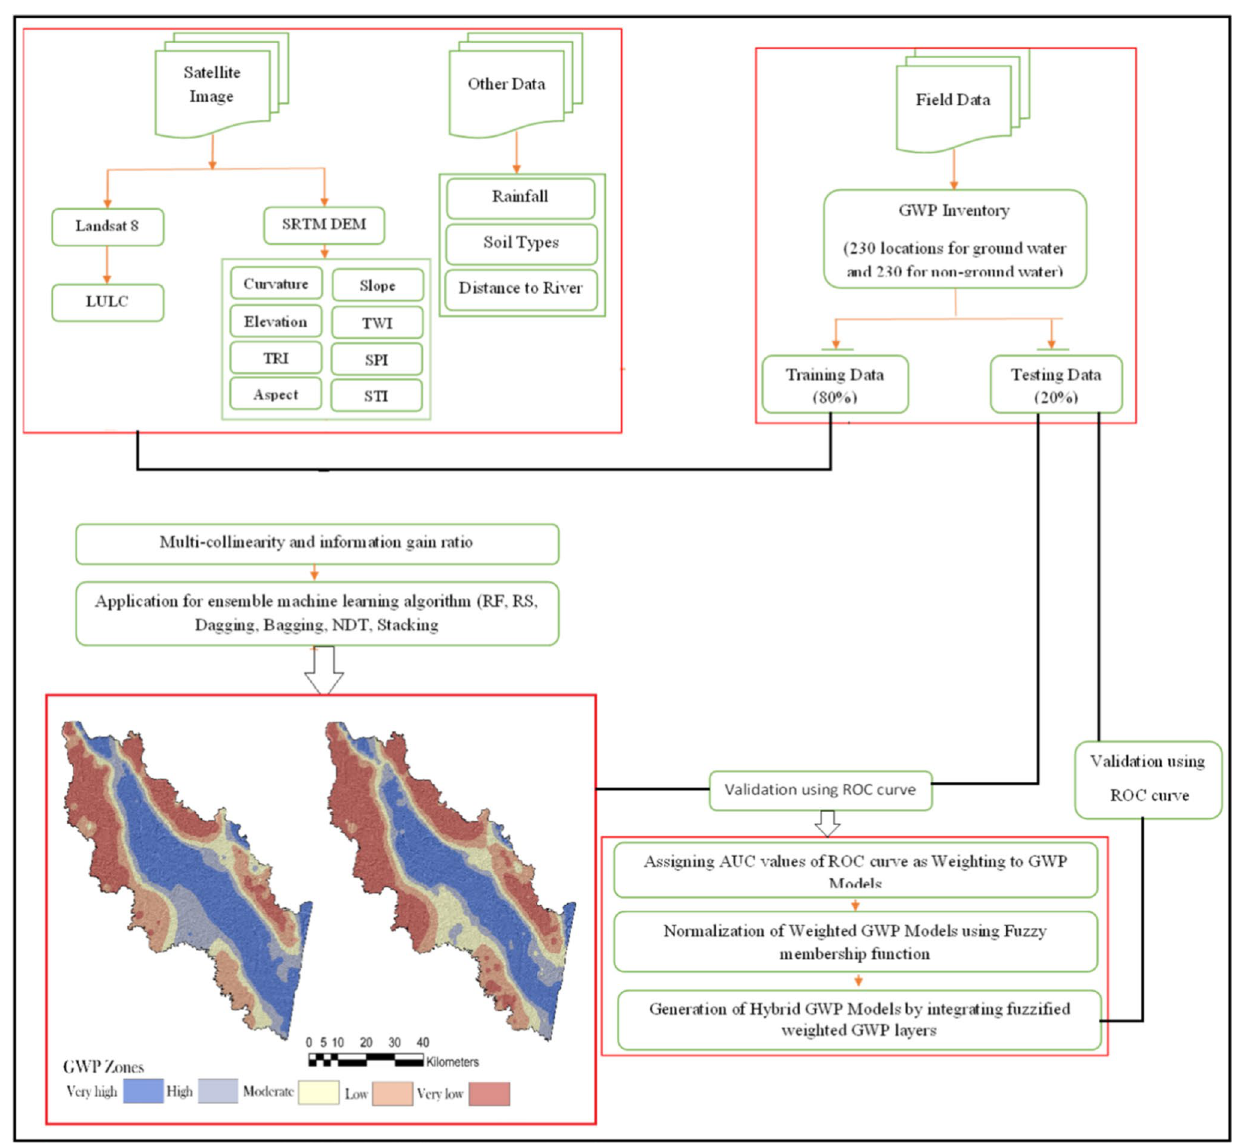
Fig. 4 Flowchart shows the steps for preparing the hybrid GWP